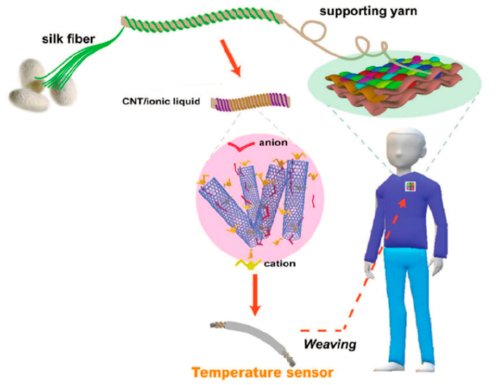
Figure 11. Fabrication of a temperature sensor containing CNTs and silk modified and reproduced with permission from [177], Copyright Wiley-VCH (2019).